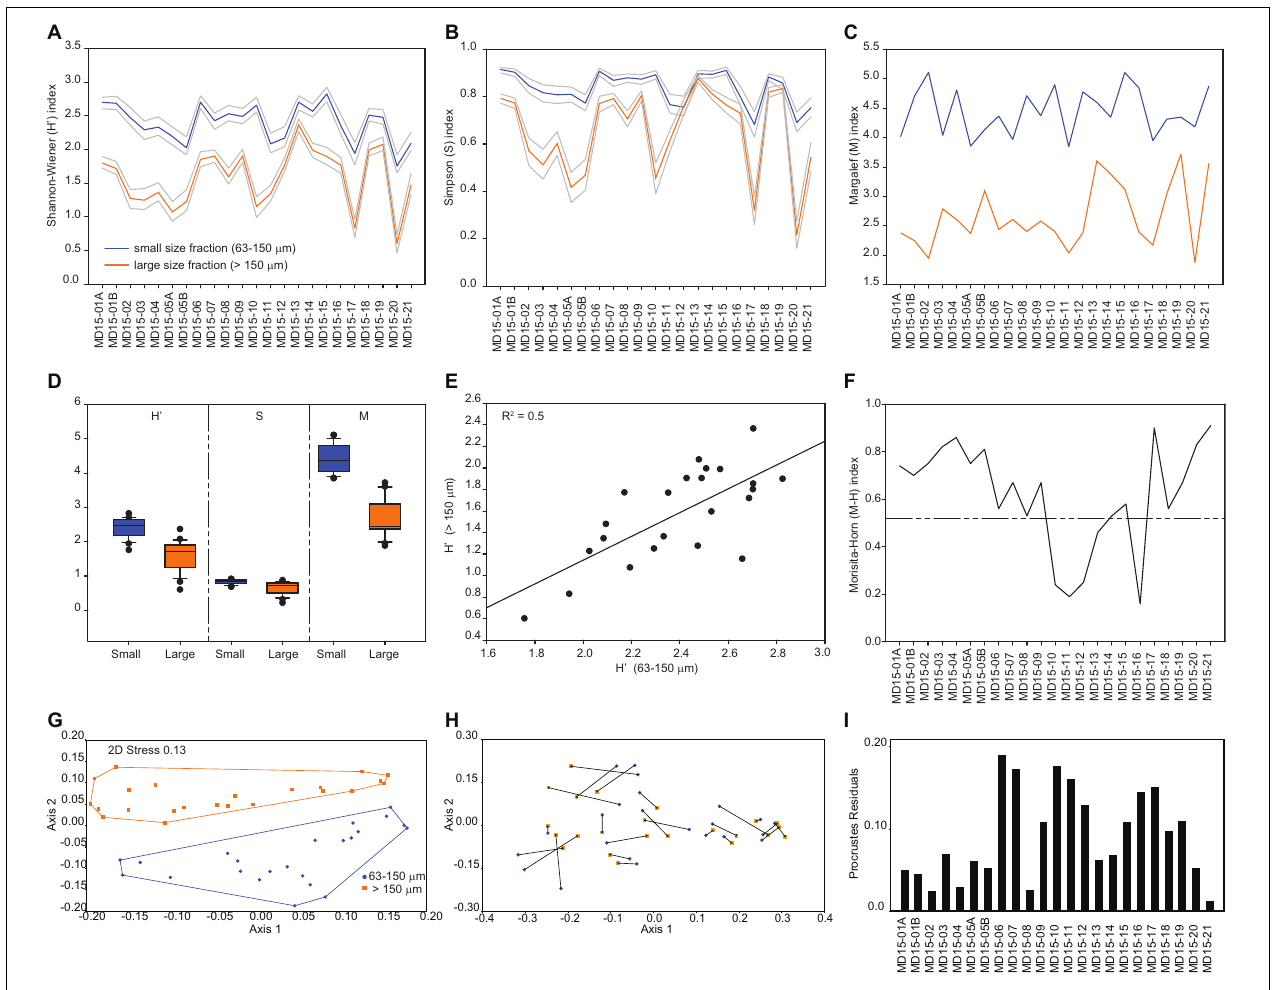
FIGURE 1 | Analyses of benthic foraminiferal assemblages. (A) Shannon-Wiener index. (B) Simpson index. (C) Margalef index. (D) Biodiversity and richness box plots. (E) Correlation between Shannon-Wiener index values from the two size fractions. (F) Morisita-Horn index. (G) Non-metric multidimensional scaling of benthic foraminiferal assemblages from the small (blue) and large (orange) size fractions based on Bray–Curtis similarity and relative abundance data. Note that axis 1 explains 60% of the total variability between sample sets. (H) Procrustes transformation on the MDS ordinations of both size fractions (small to large). (I) Procrustes